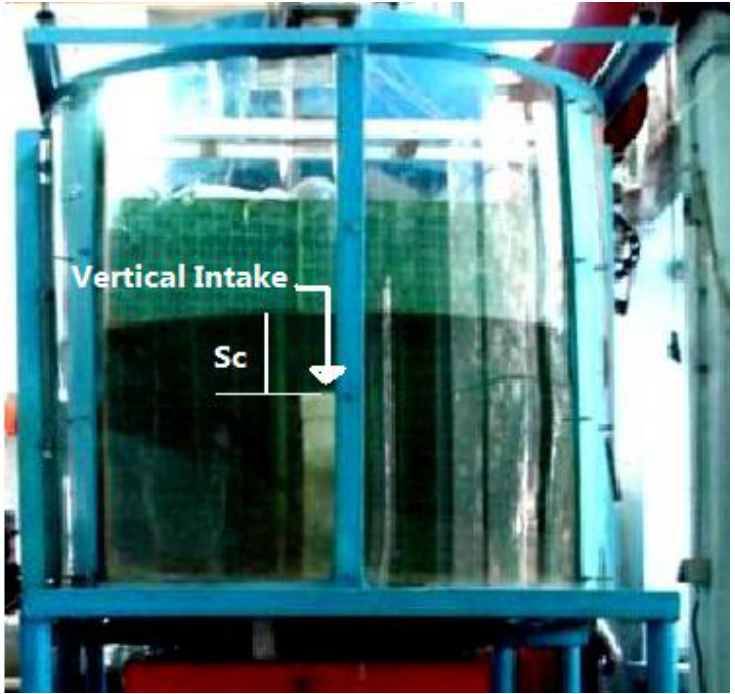
Fig. 1 The vertical intake used in the present